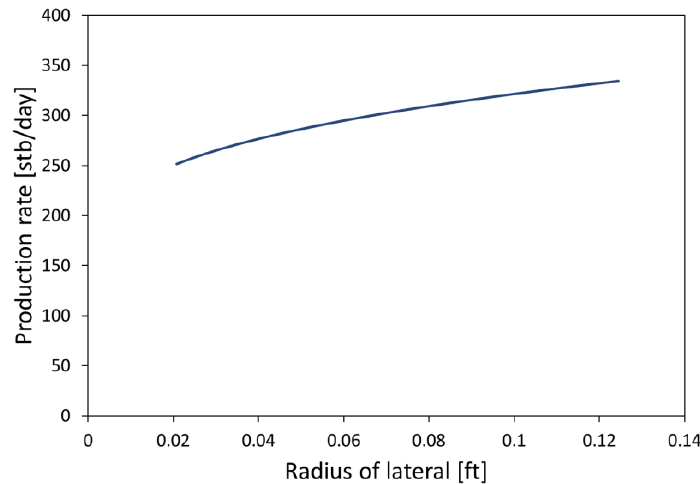
ff ect of lateral radius on well production rate (Well Figure 12. Modeled effect of lateral radius on well production rate (Well #1). Figure 12. Modeled e